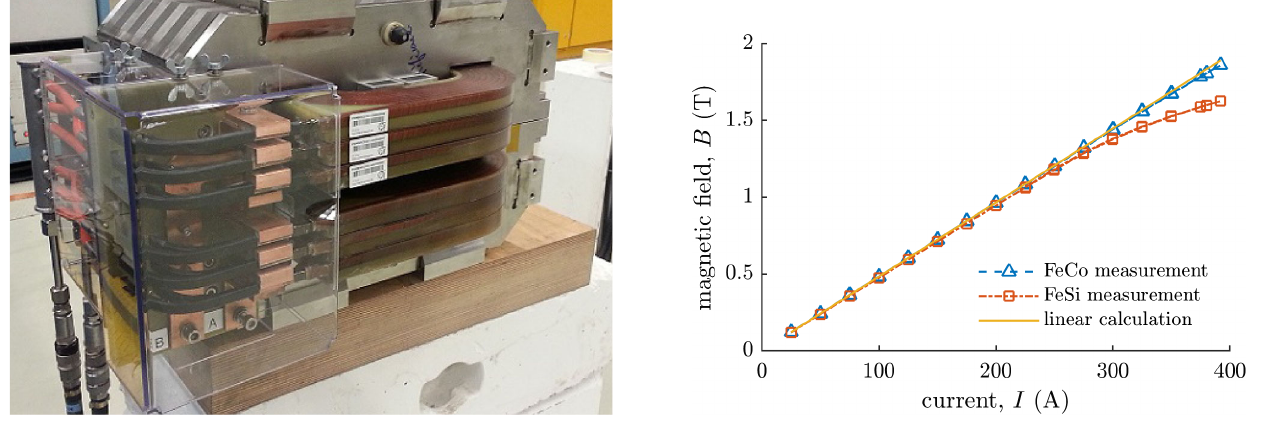
FIG. 15. Assembled magnet. FIG. 16. Center magnetic field as a function of